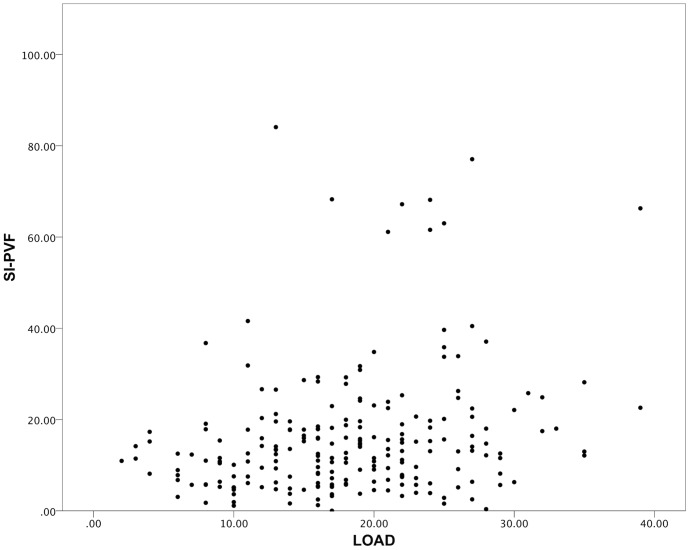
Scatterplot of LOAD versus SI-PVF scores for the cross-sectional cohort.There is a significant, weak correlation. Spearman’s Rank Correlation Coefficient = 0.23 (p<0.01).